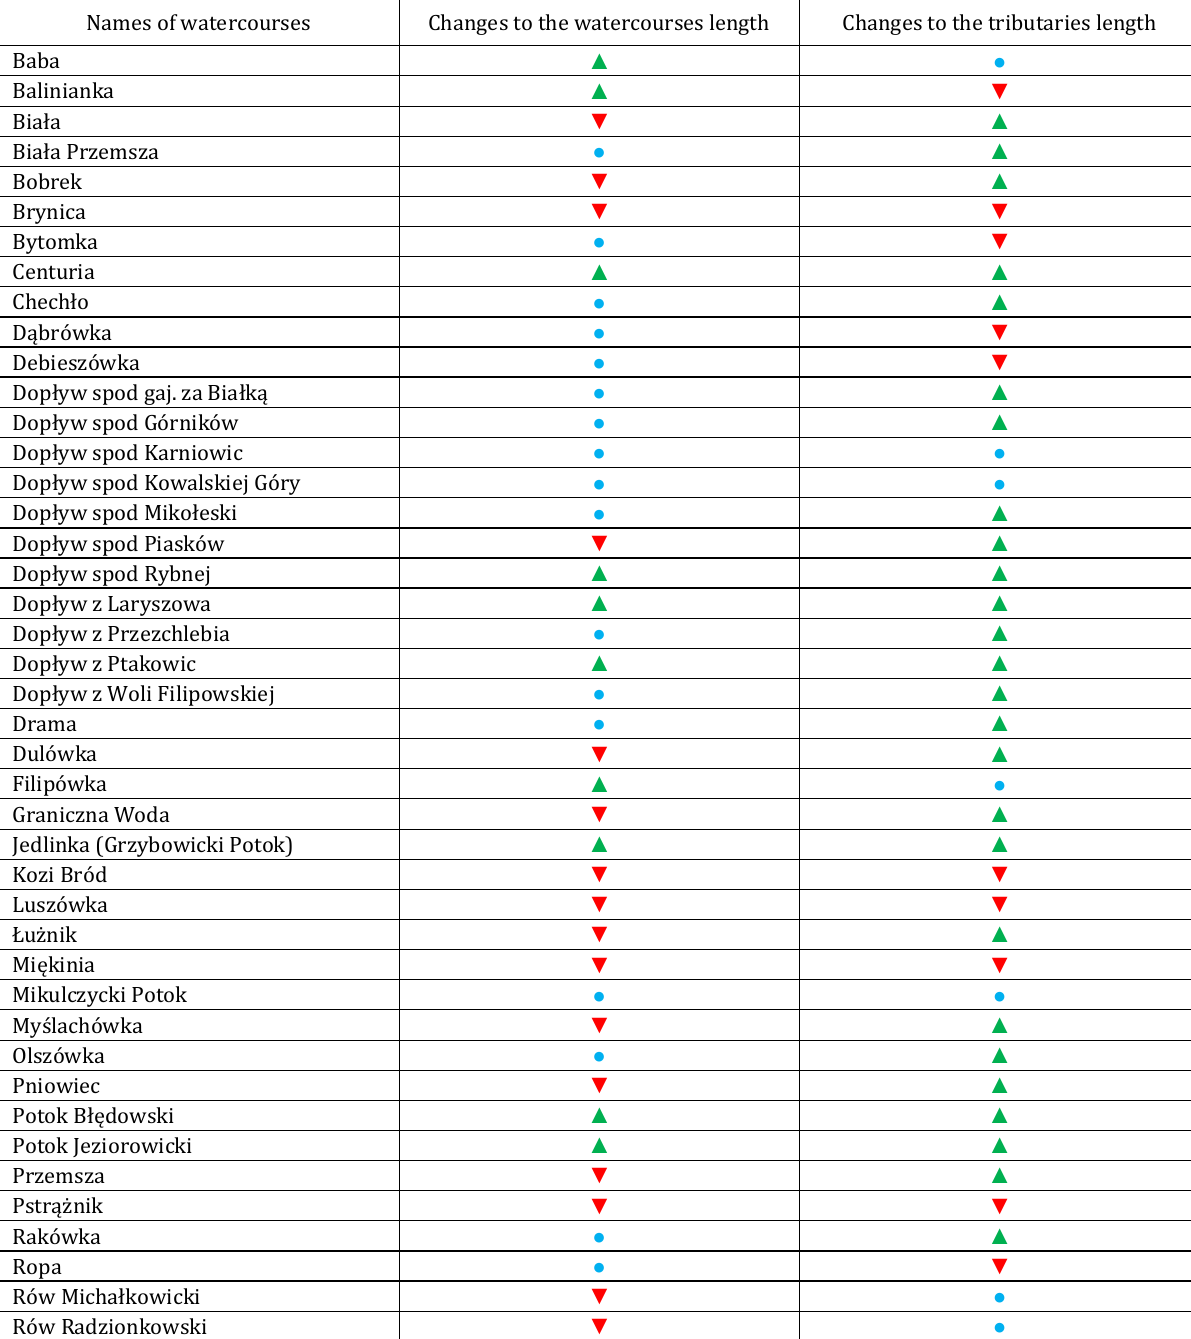
Table 1. The statement of watercourse lengths (private study based on databases) Names of